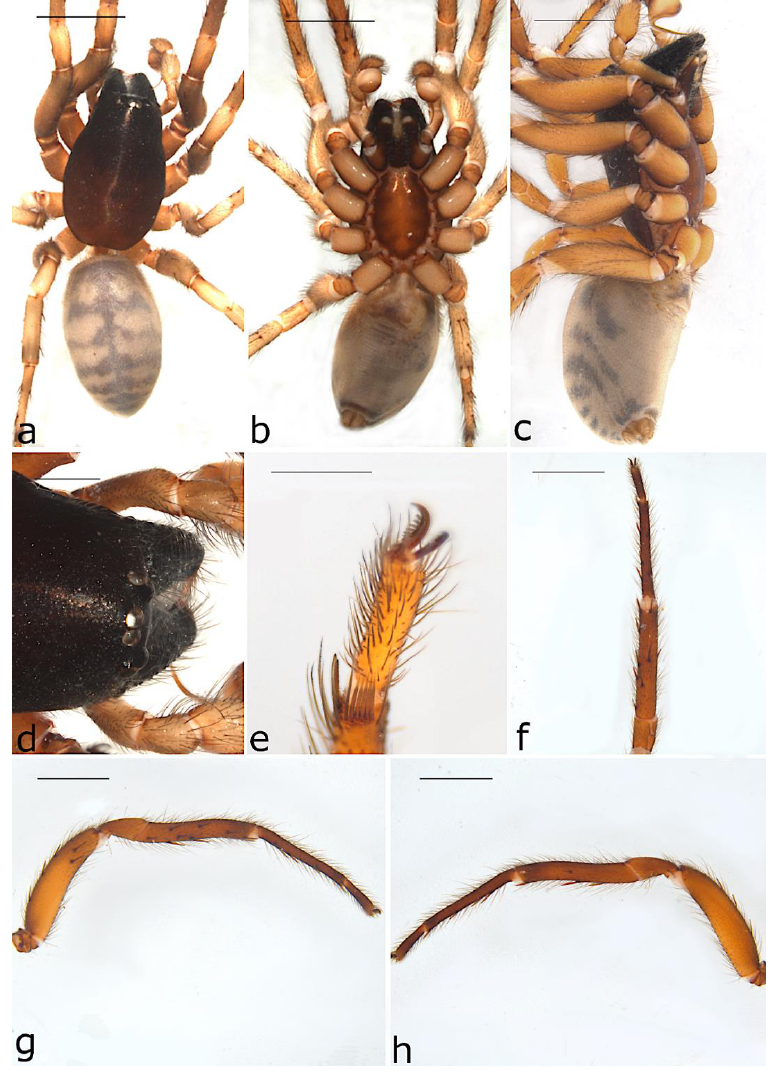
Figure 4. Ariadna clavata Marsh, Baehr, Glatz & Framenau, 2018. ♂ holotype (SAMA NN29861) from Kangaroo Island (SA): ( a ) habitus, dorsal view; ( b ) same, ventral view; ( c ) same, lateral view; ( d ) eyes, dorsal view; ( e ) left metatarsus IV, preening comb, retrolateral view; ( f ) left leg I, ventral view; ( g ) same, prolateral view; and ( h ) same, retrolateral view. Scale bars ( a – d , f – h ) = 1 mm and ( e ) = 0.5 mm.